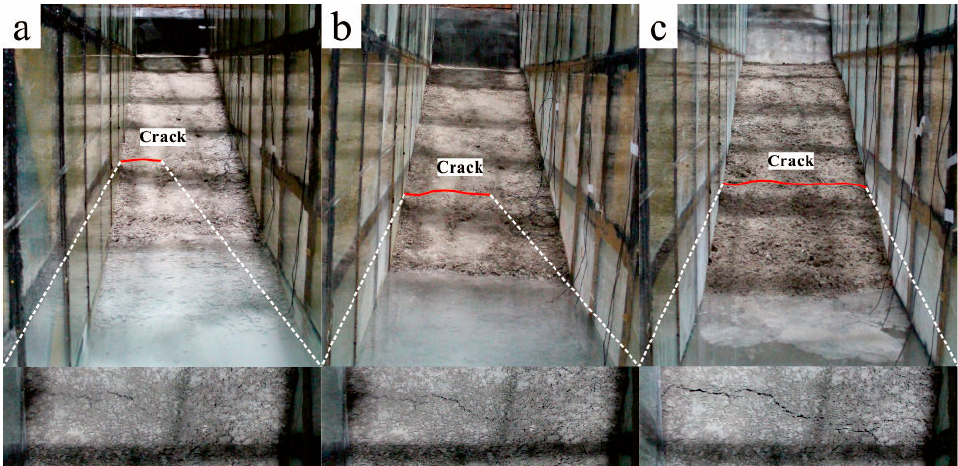
Figure 13. Water lowering processes combined with rainfall simulations of the induced landslide process: ( a ) Cracking occurred in the middle of the landslide with a water elevation of 43.54 cm; ( b ) Crack propagation with a water elevation of 41.25 cm; ( c ) Crack penetration with a water elevation of 40.18 cm.